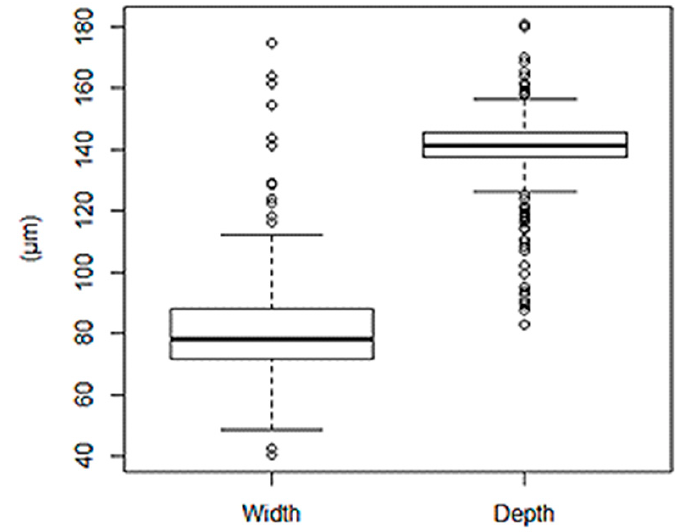
Figure 9. Multiple box plot of the microchannel.